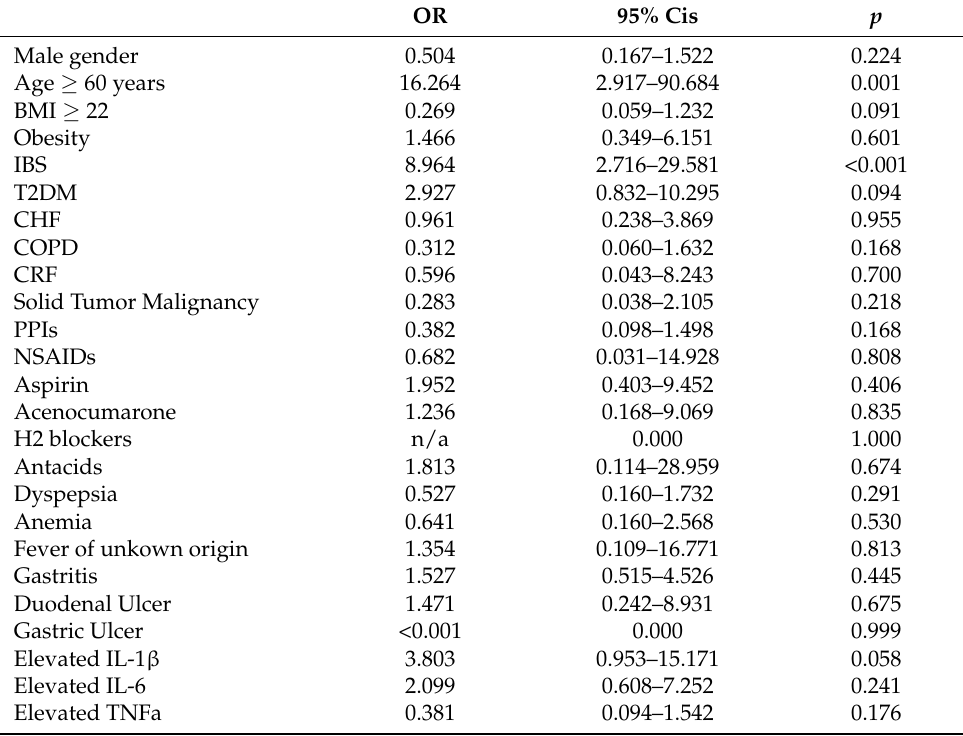
Table 2. Univariate analysis of independent factors and their relationship with SIB.